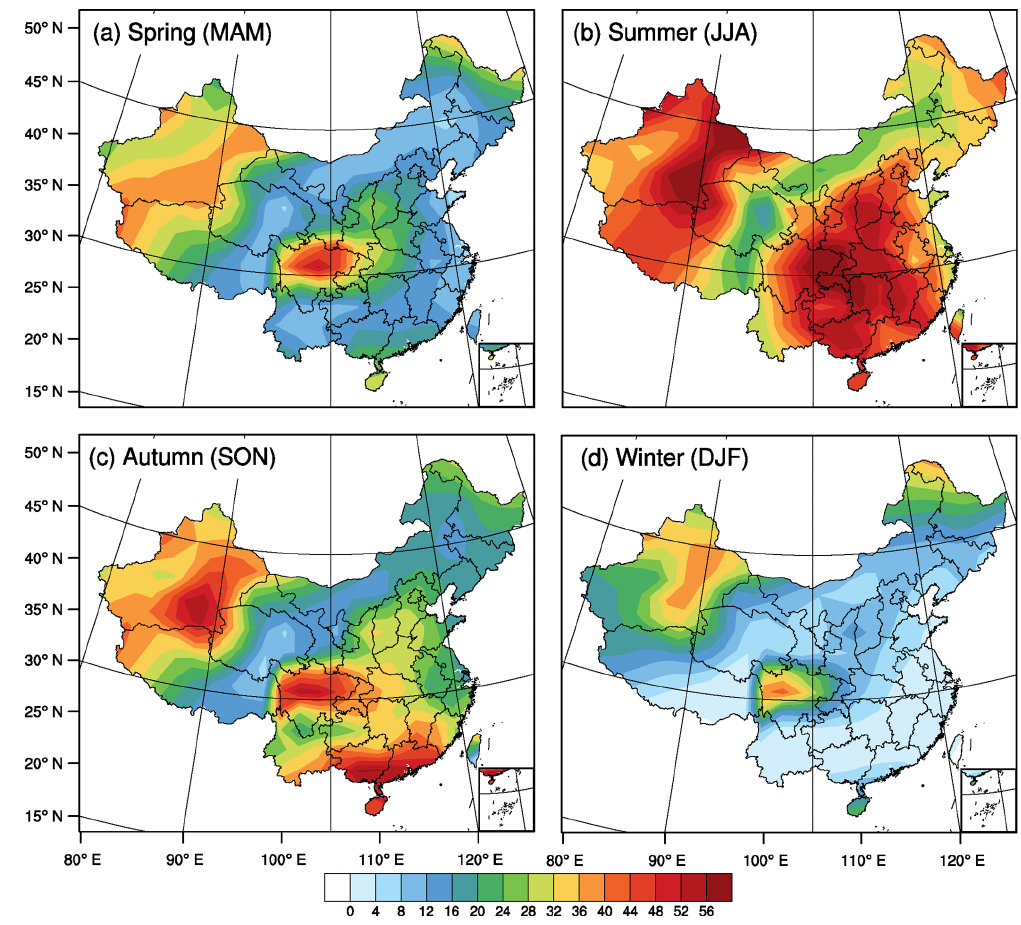
Figure 3. Average air stagnation days in spring (a) , summer (b) , autumn (c) , and winter (d) during 1985–2014.